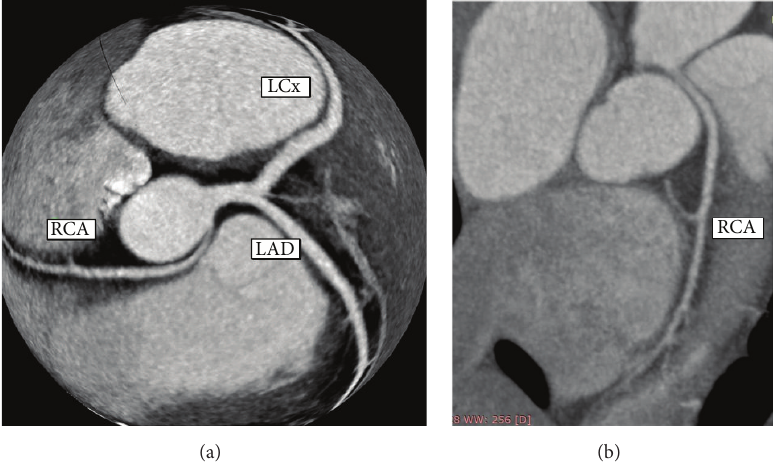
Figure 3: (a) and (b) Cardiac MSCT shows RCA originated from left sinus of Valsalva adjacent to LCA ostium with interarterial course between ascending aorta and pulmonary artery. The caliber of RCA was small and coursed into right atrioventricular